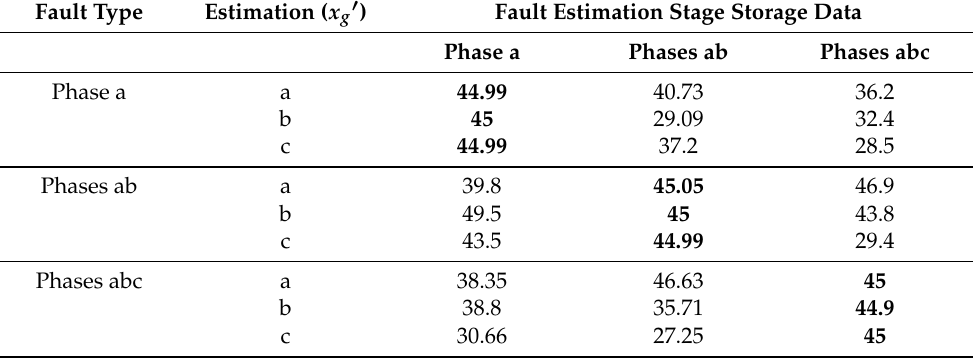
Table 8. Test fault location of 45 km having different scenarios of fault types and its estimation by the pseudo and hybrid